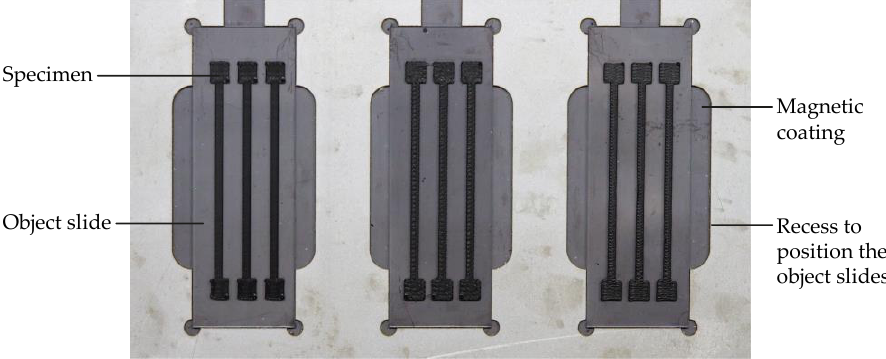
Figure 5. Representation of the additive manufacturing process of test specimens for characterization of resistivity on object slides exemplarily shown based on preliminary investigations with different raster angle orientations.